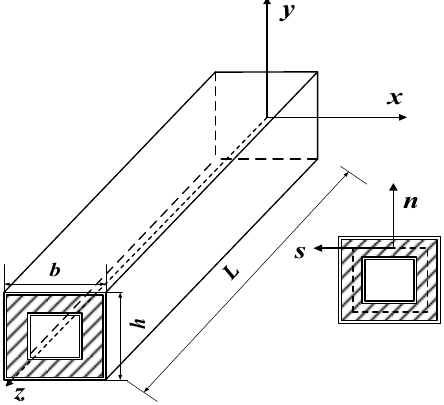
Figure 13. Composite sandwich laminated box beam coordinate system.